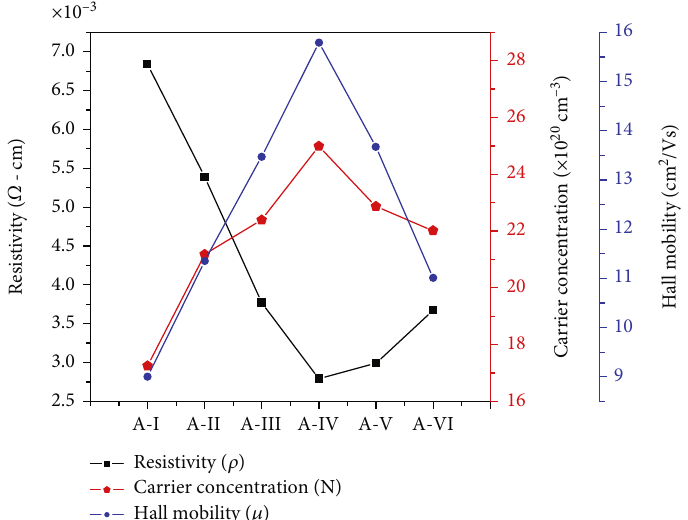
Figure 12: Resistivity analysis of various samples.